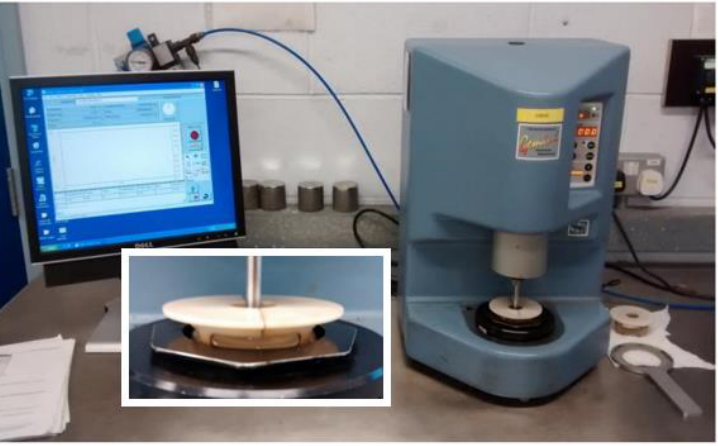
Figure 2. Dynamic shear